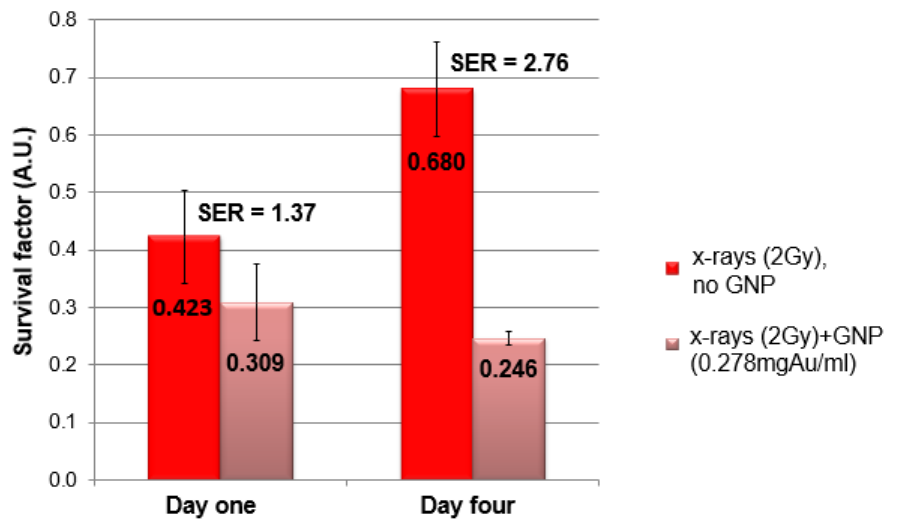
Figure 7. Radiation treatment response wo/w GNPs in a 3D model. Treatment enhancement de- pended on localization of GNPs. Bars with SE ( n = 3) represent the post-radiation clonogenic survival factors wo/w GNPs after one day and four days of accumulation. The presence of GNPs enhanced radiation effectiveness, but a four-day accumulation period showed doubled SER, compared with one day (ml = mL).